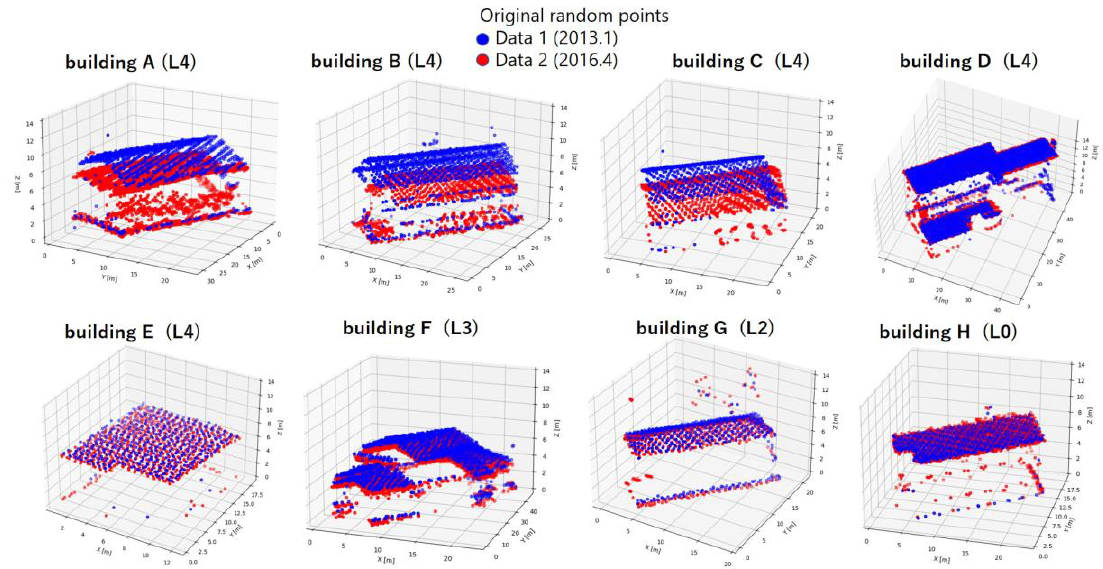
Figure 12. A 3D plot of the random point data for eight buildings ( A – H ) in Figure 11. Blue points for Dataset 1 (2013.1) and red points for Dataset 2 (2016.4).